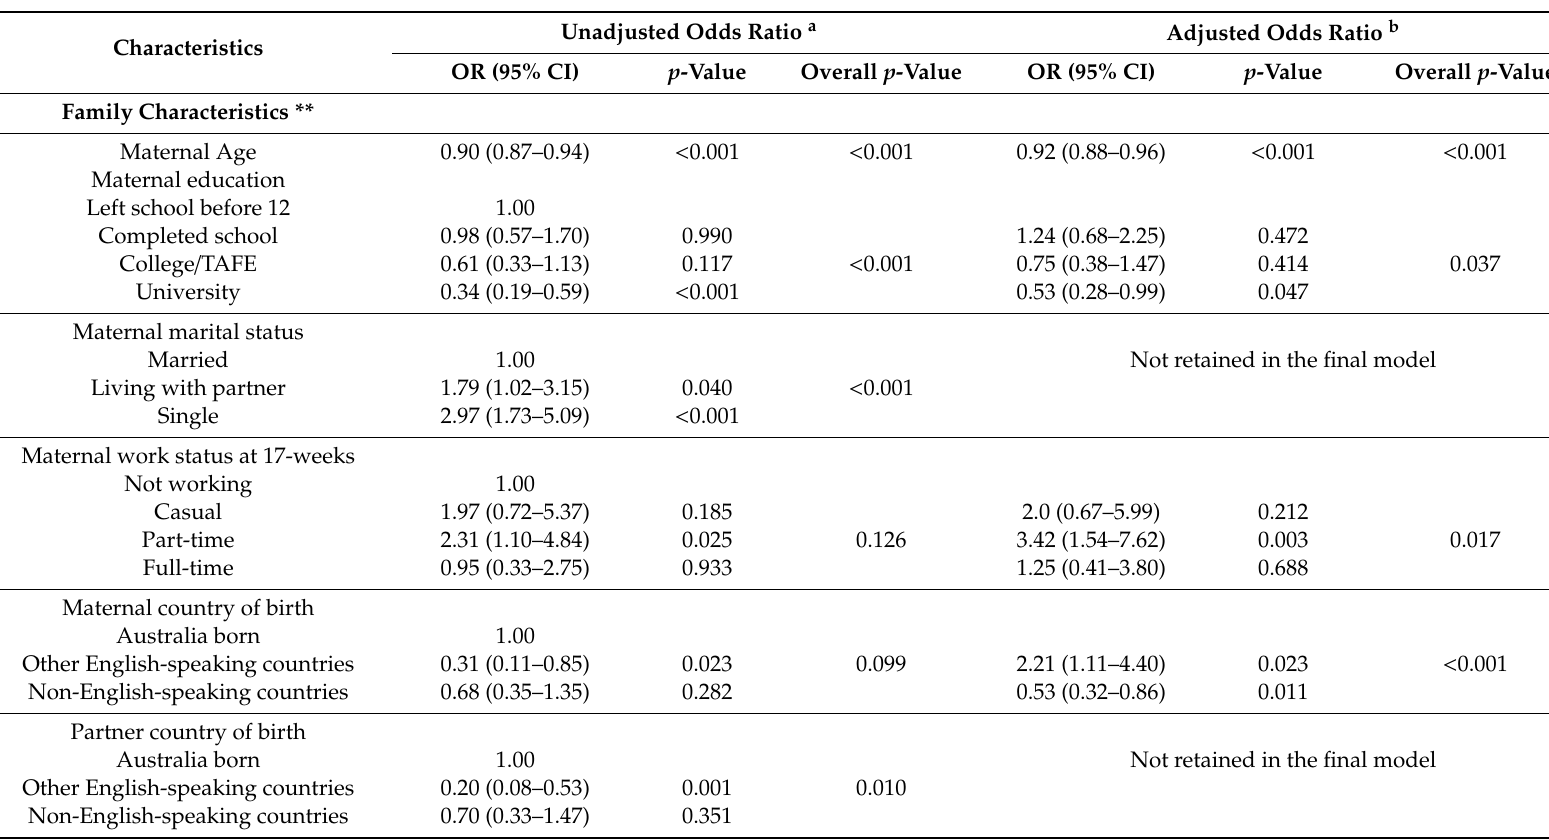
Table 2. Unadjusted and adjusted odds ratio (OR) for early introduction of core foods ( < 17 weeks).